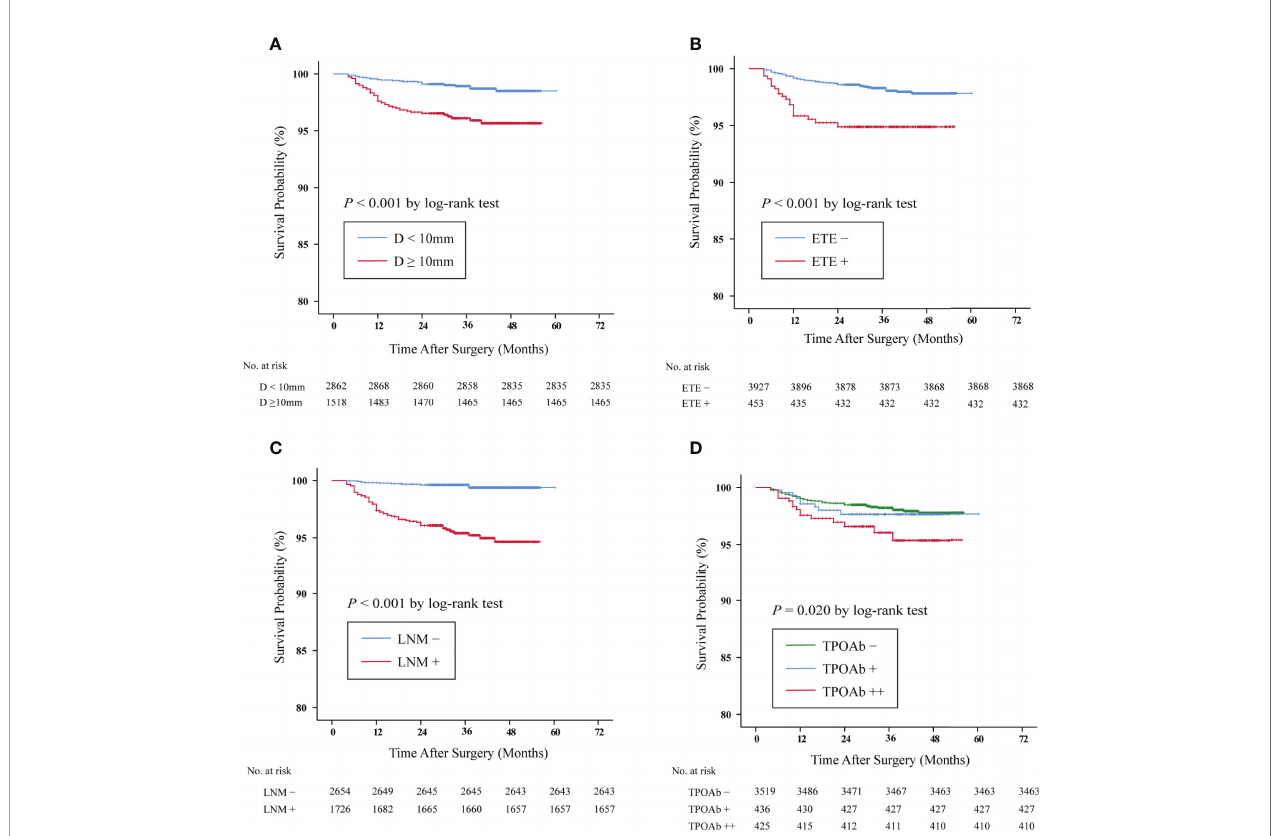
FIGURE 2 | Kaplan – Meier survival curves of disease-free survival (DFS) in papillary thyroid carcinoma (PTC) patients. The DFS rates of PTC patients with (A) tumor size ≥ 10 mm vs. <10 mm: 96.5 vs. 99.1%, p < 0.001. (B) Extrathyroidal extension (ETE) + vs. ETE – , 95.4 vs. 98.5%, p < 0.001. (C) Lymph node metastasis (LNM)+ vs. LNM – : 96.0 vs. 99.6%, p < 0.001. (D) The DFS rates of the TPOAb++ group were signi fi cantly lower than those of the TPOAb – group ( p = 0.020 by log-rank test, TPOAb++ vs. TPOAb − , p = 0.005; TPOAb++ vs. TPOAb+, p = 0.195; TPOAb+ vs. TPOAb − , p = 0.476). TPOAb − , 0 < TPOAb ≤ 100 IU/L; TPOAb+, 100